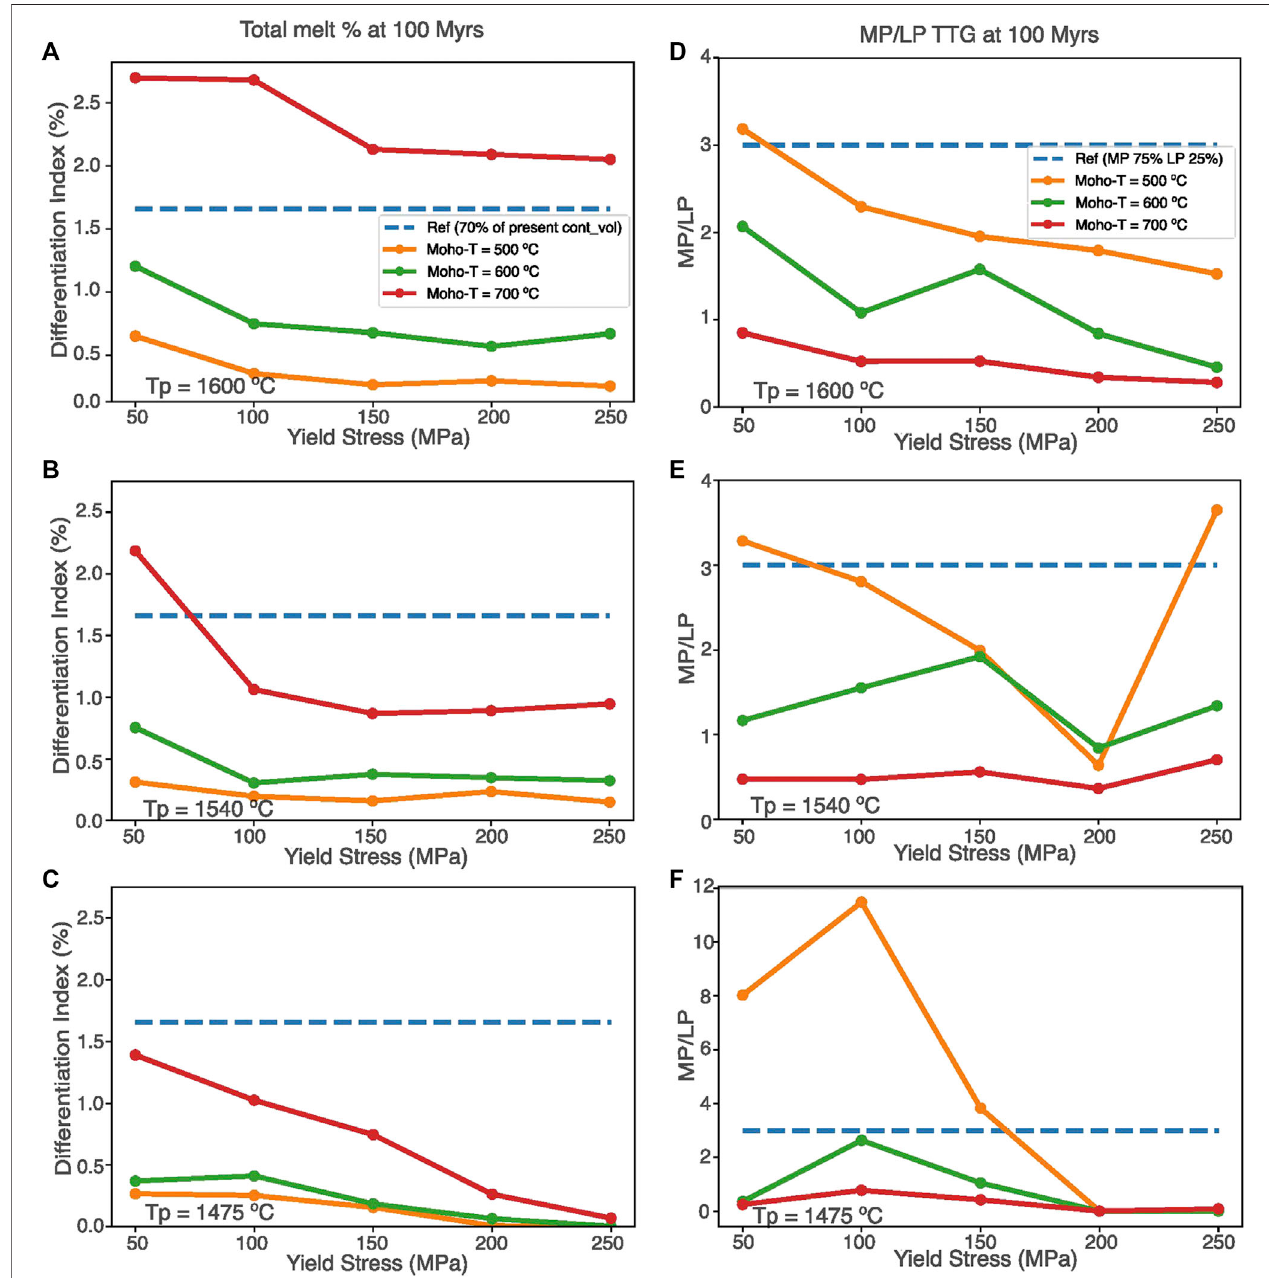
FIGURE 7 | Plots showing (A – C) the total tonalite-trondhjemite-granodiorite (TTG) crustal volume cast in terms of the Differentiation Index (DI) value and (D – F) the proportions of low-pressure (LP-) to medium-pressure (MP-)TTGs as a function of lithospheric yield stress, as obtained from our numerical models with different mantle T p and Moho-T values. The DI values are computed at the end of the fi rst 100 Myr of the model evolution in each case. The dashed blue lines in (A – C) represent the geologicallyconstrainedDIvalue( ≥ 1.7)at3 Ga,whilein (D – F) theyrepresenttherelativeproportionoftheLP-toMP-TTGsaspreservedintherockrecord(seetext fordetails).Notethatthemodelswithlowlithosphericyieldstresses(athottermantle andmoderatehotterMohoconditions) producetheDIvaluesthatarelikelytoresult a continental volume of 70% of its present-day value (DI (cid:3) ∼ 1.7) in few hundreds of Myr while matching the rock-record of the proportions of LP- and MP-TTGs.